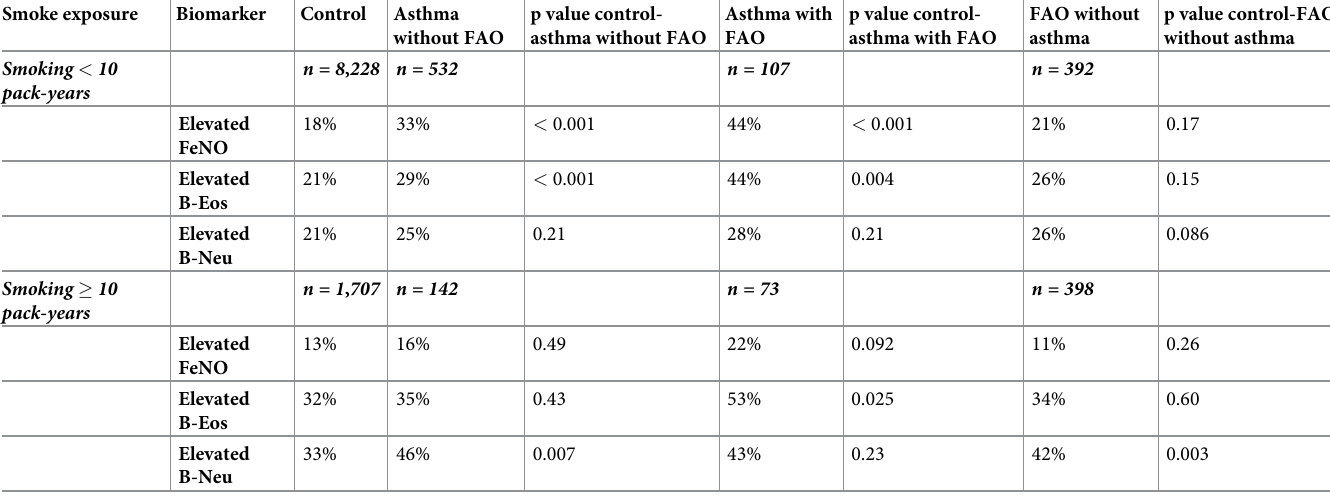
Table 3. Percent with elevated markers (FeNO � 25ppb, B-Eos � 300 cells/ μ L, B-Neu � 5100 cells/ μ L) in the asthma and FAO groups compared with controls, strati- fied by total smoke exposure ( < 10 or � 10 pack-years). Smoke